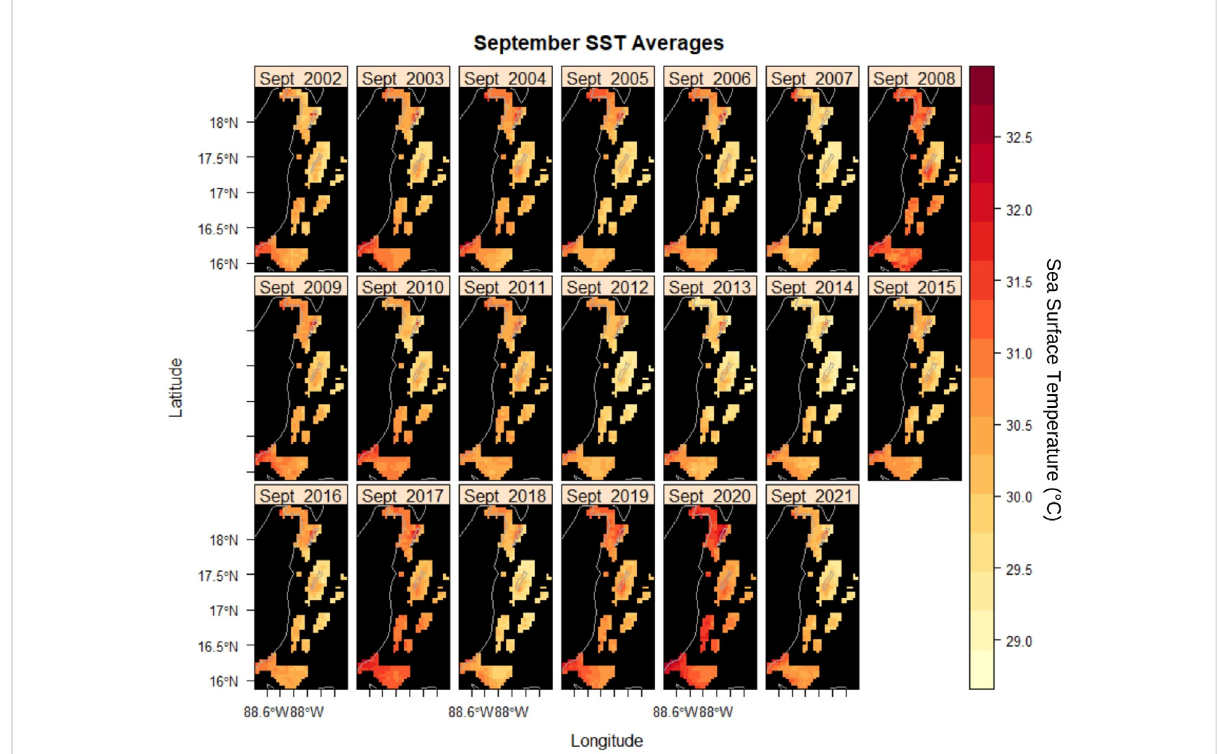
FIGURE 4 Mapsshow meansea surfacetemperaturefor themonthofSeptember(hottest month) inMarineProtected Areas ofBelizefrom 2002to 2022.